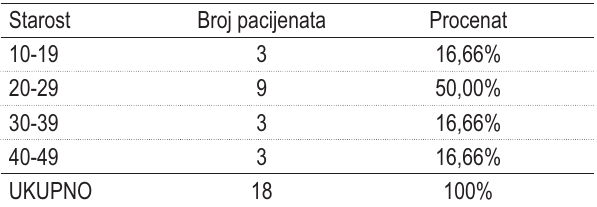
TABELA 3. Broj ženskih pacijenata ukljuwenih u istraživanje svrstanih prema starosnoj